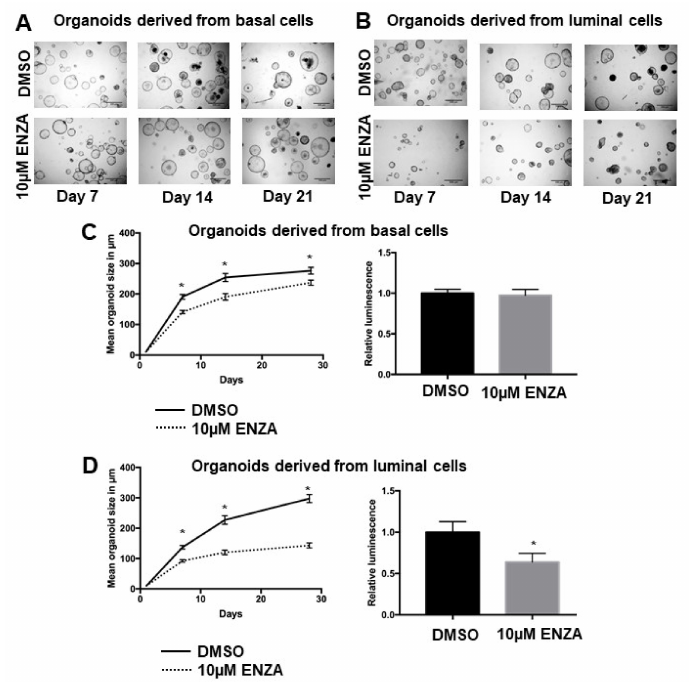
Figure 2. Growth patterns and viability of TRAMP tumor organoid lines. Brigthfield microscope pictures of basal cell-derived ( A ) and luminal-cell-derived ( B ) organoid cultures treated with DMSO (upper panel) or enzalutamide (lower panel). Scale bars represent 500 µ m. ( C , D ) Both luminal and basal cell-derived organoids exhibit significantly smaller organoid size upon treatment with 10 µ M enzalutamide when compared to DMSO, although decreases in organoid size are more pronounced in luminal cell-derived organoids (left panels). Interestingly, luminal cell-derived organoids but not basal cell-derived organoids exhibit lower viability as determined by luminescence upon treatment with enzalutamide. Measurements as described in the methods section of five biological replicates with three technical replicates each are shown. Error bars represent SEM (( C , D ) bar graphs).